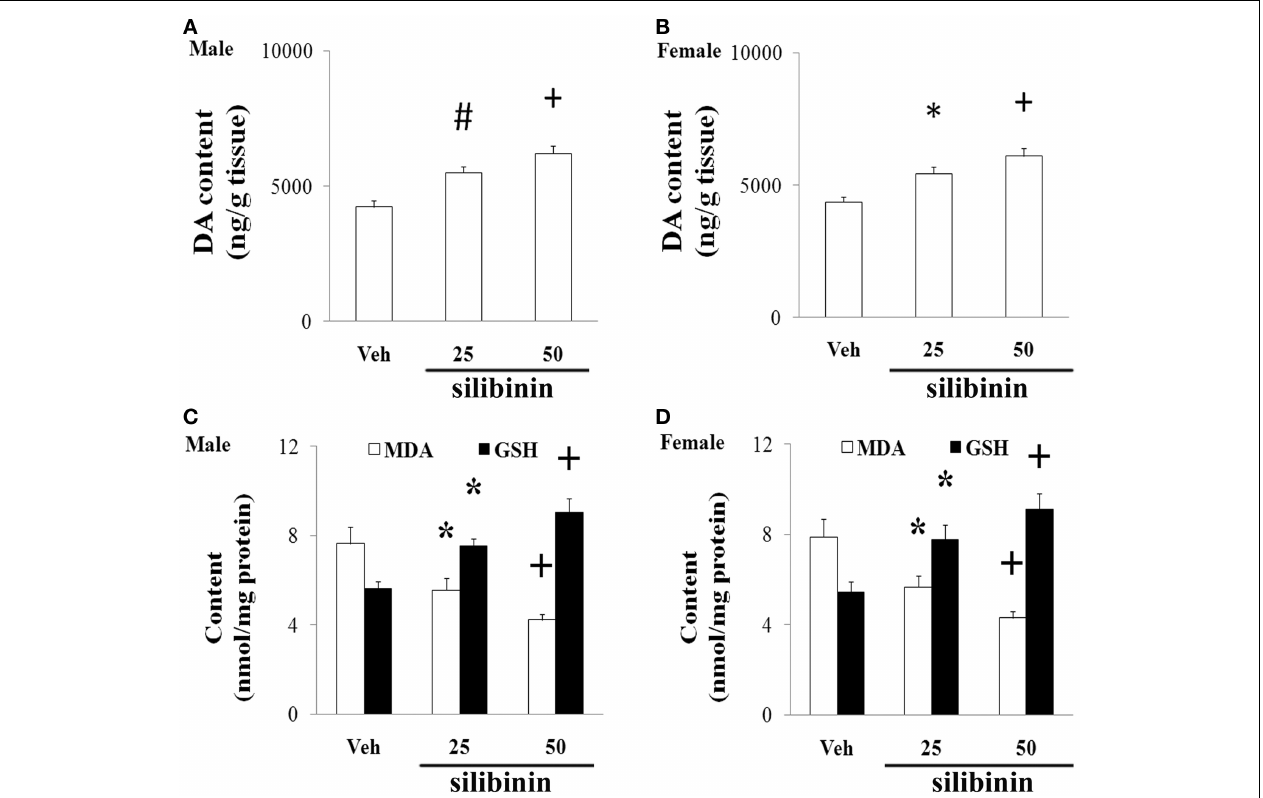
FIGURE 7 | Effect of silibinin treatment on striatal DA content and SN MDA and GSH content in aging male (A,C) and female (B,D) rats with increased neonatal iron intake . Results are expressed as mean ± SEM. N = 8–10. * p < 0.05, # p < 0.01, and + p < 0.005, compared with the aging rats treated with Veh. DA, dopamine; Veh, vehicle; MDA, malondialdehyde; GSH,